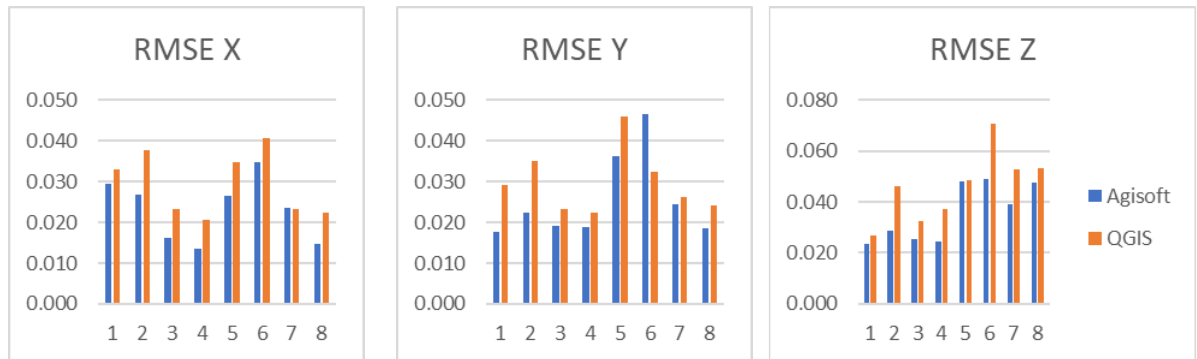
Figure 10 RMSE values from Agisoft and QGIS 1 - Variant 6 PPK a6000, 2 - Variant 6 PPK RX, 3 - Variant 6 NAV/GCP a6000, 4 - Variant 6 NAV/GCP RX, 5 - Variant 5 PPK a6000, 6 - Variant 5 PPK RX, 7 - Variant 5 NAV/GCP a6000, 8 - Variant 5 NAV/GCP